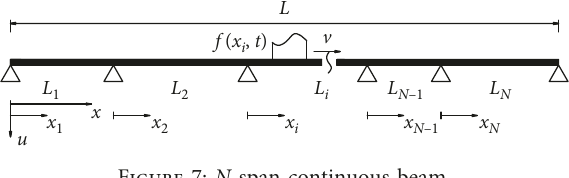
Figure 7: N -span continuous